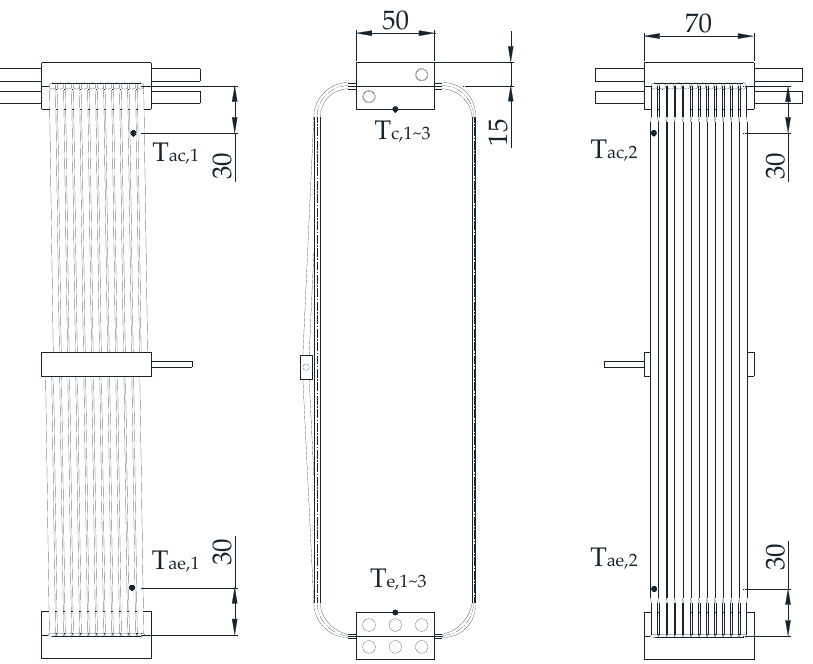
Figure 7. Dimensions of heating block and cooling block, and the locations of the thermocouples (Unit: mm).